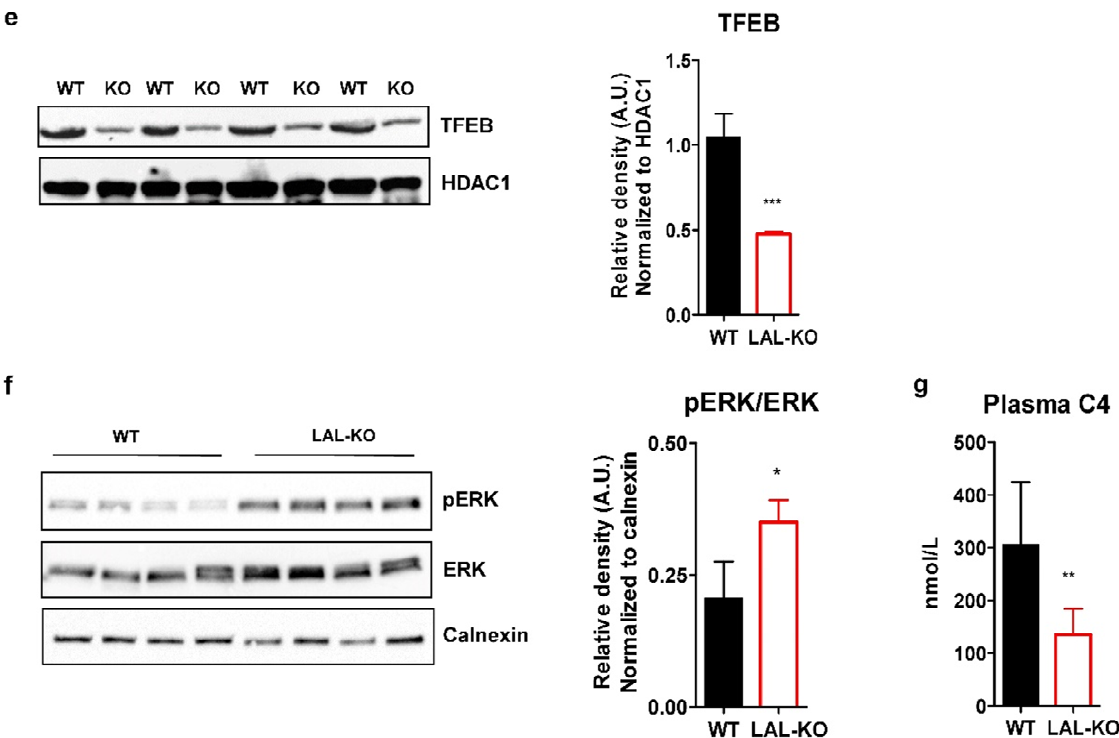
Figure 4. Altered FGF15 signaling in LAL-KO mice: Relative transcript levels of ( a ) ileal and ( b ) hepatic genes relative to cyclophilin A as reference gene (n = 4). ( c ) Plasma FGF15 concentrations in WTD-fed mice (12–14 weeks old) fasted for 12 h (n = 7–8). Hepatic protein expression of ( d ) CYP7A1, ( e ) nuclear TEFB, and ( f ) phosphorylated and total ERK including quantification to their loading controls. ( g ) Plasma C4 concentrations (n = 6). Data represent mean values + SD; p < 0.05 (*), p ≤ 0.01 (**), p ≤ 0.001 (***); Student’s unpaired t-test.